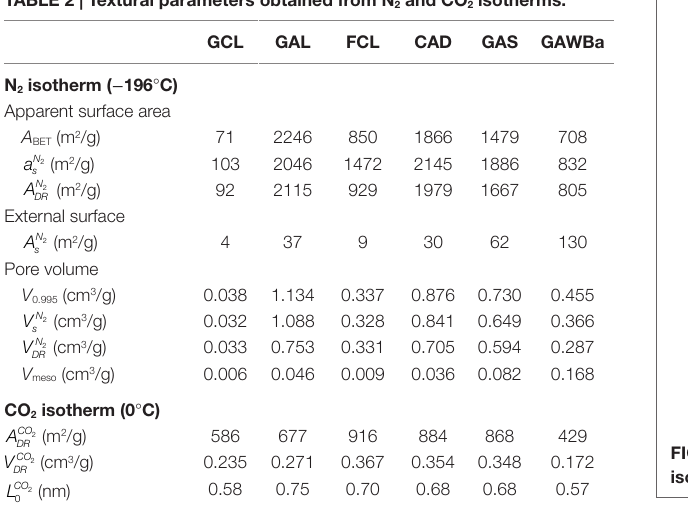
TaBle 2 | Textural parameters obtained from n 2 and cO 2